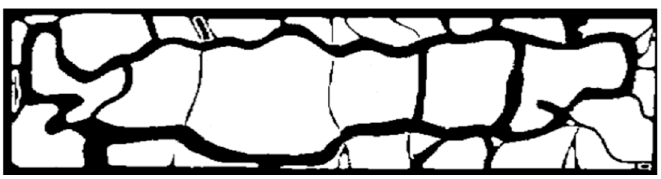
Figure 2. 800 × 4000 pixel monochrome map of Central Park used as the target environment ( black : Figure 2. 800 ˆ 4000 pixel monochrome map of Central Park used as the target environment roads/trails; white : lawn areas). ( black : roads/trails; white : lawn